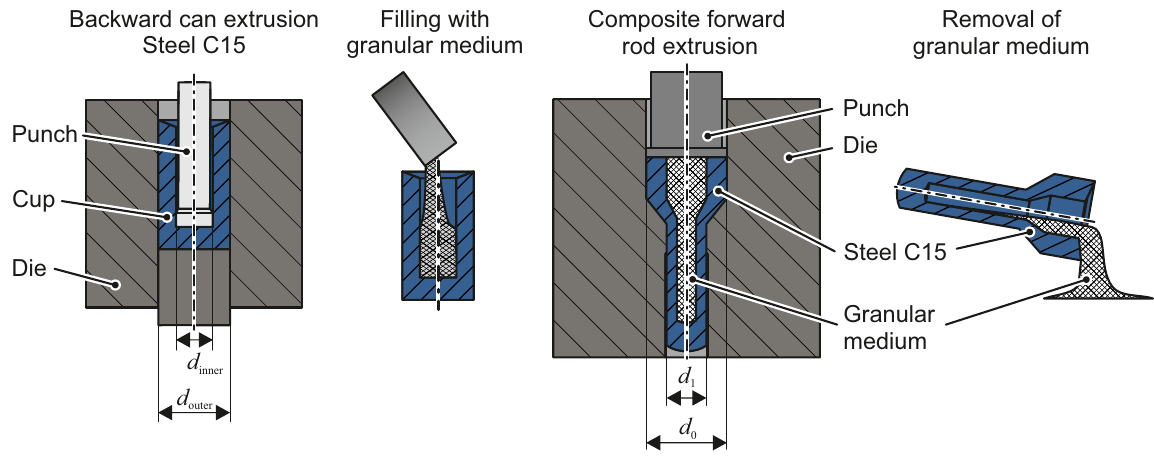
Figure 10. Process route for production of hollow shafts by means of cold forging with granular media.